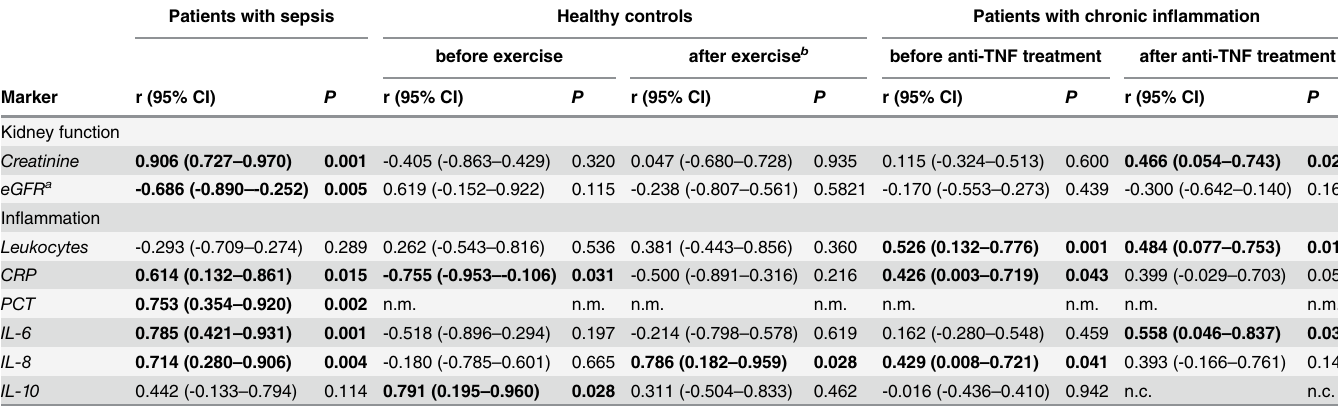
Table 2. Correlation of plasma-NGAL with inflammation markers and kidney function. Patients with